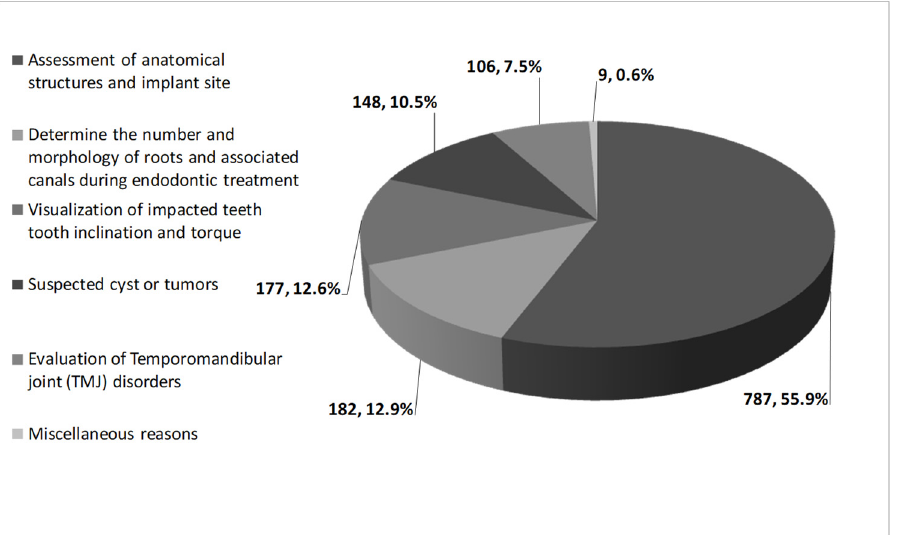
Figure 2. Indications for CBCT Use of The Study Population. Table 1. Clinical Data Regarding the Patterns of CBCT Usage According to Referring